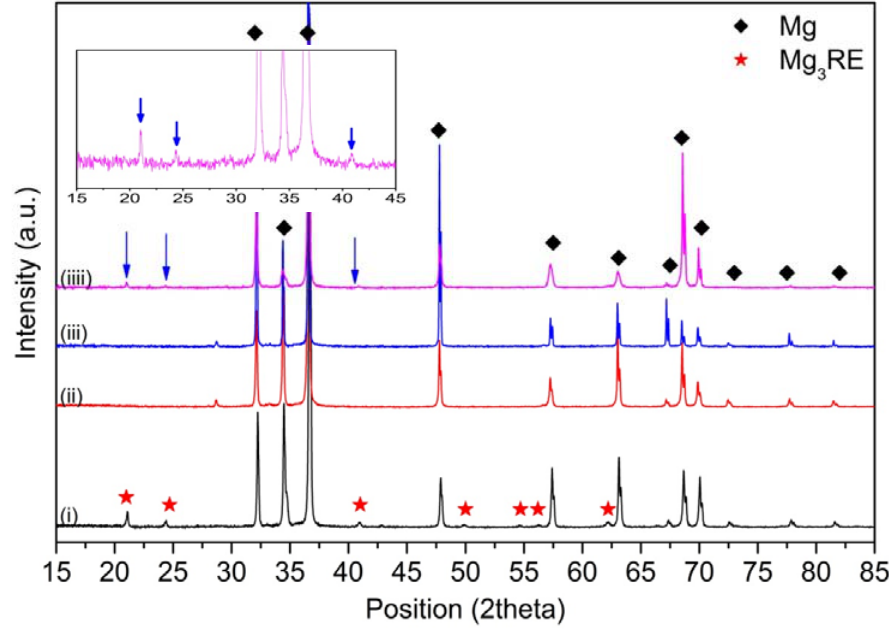
Figure 6. XRD of: (i) El21 ‐ as cast; and El21 solutionized at: (ii) 520 °C; (iii) 550 °C; and (iiii) 580 °C.